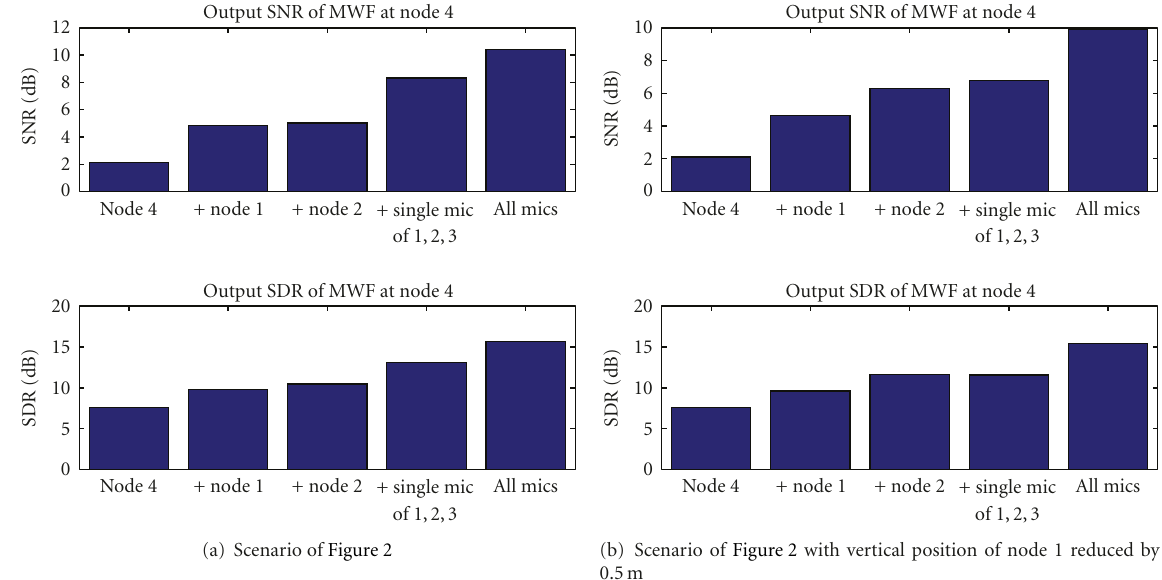
Figure 3: Comparison of output SNR and SDR of MWF at node 4 for five di ff erent microphone